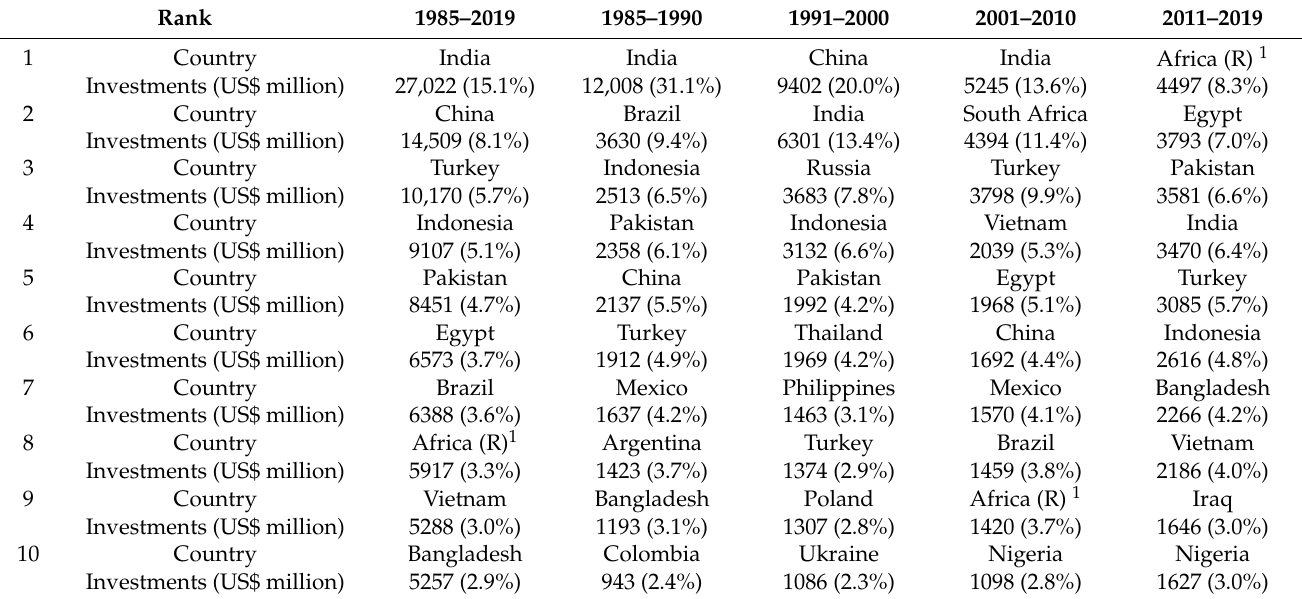
Table 3. Major recipient countries